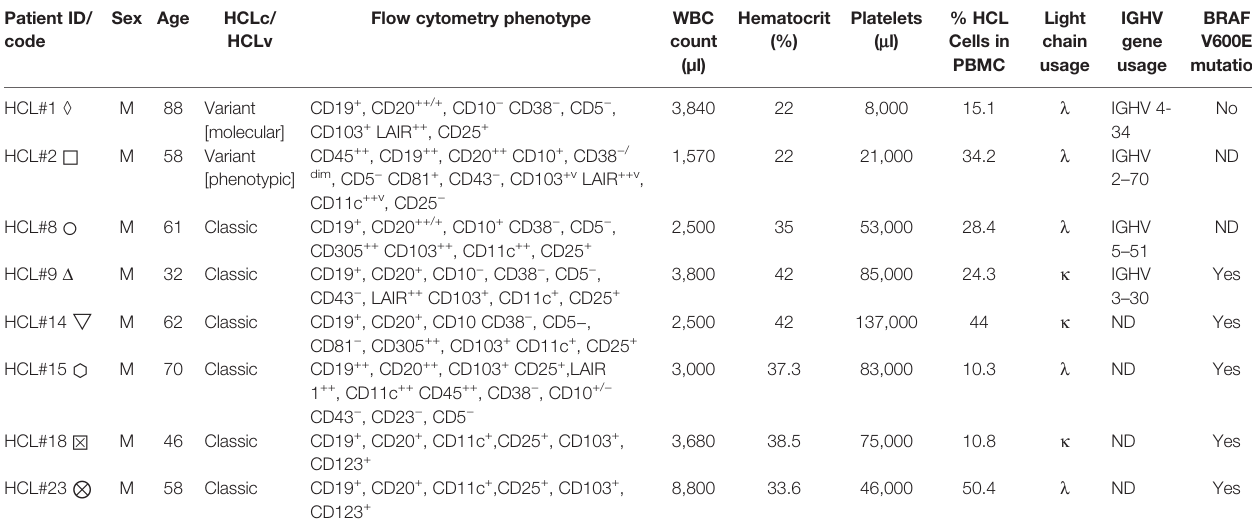
TABLE 1 | Characteristics of HCL patients included in this